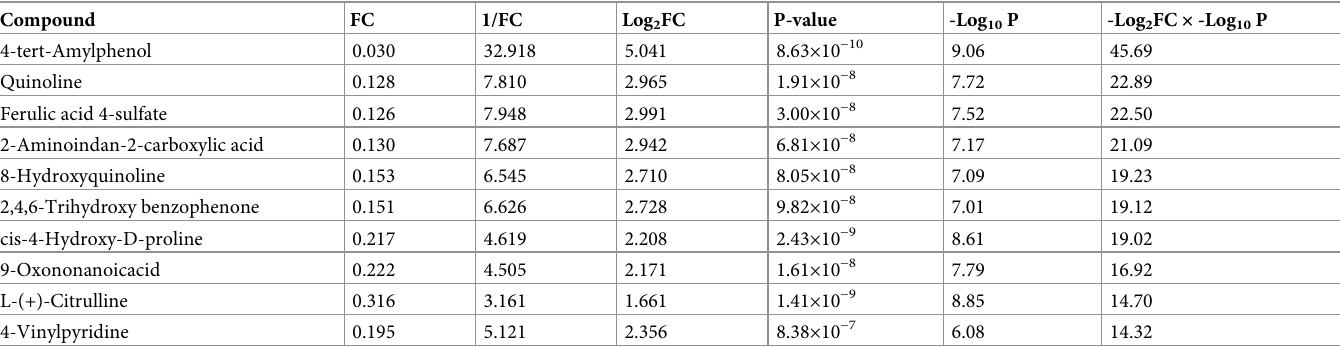
Table 4. Top 10 compounds downregulated in dogs with sepsis.